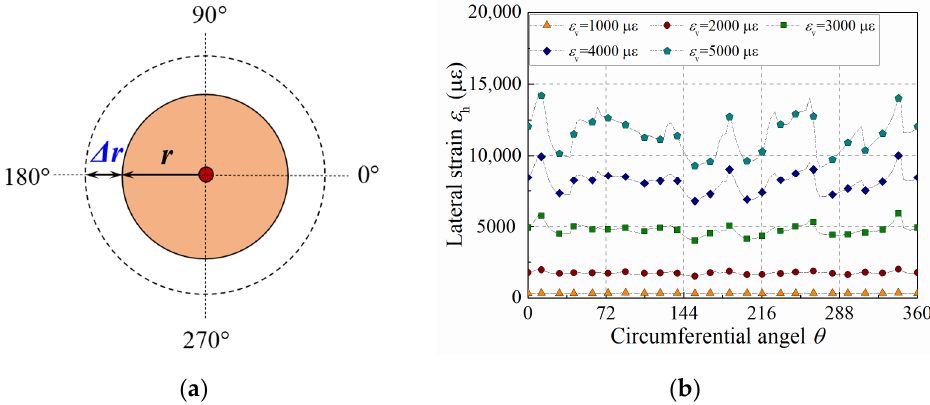
Figure 9. Distribution of the lateral strain along circumferential direction: ( a ) middle section of the specimen; ( b ) distribution of the lateral strain.